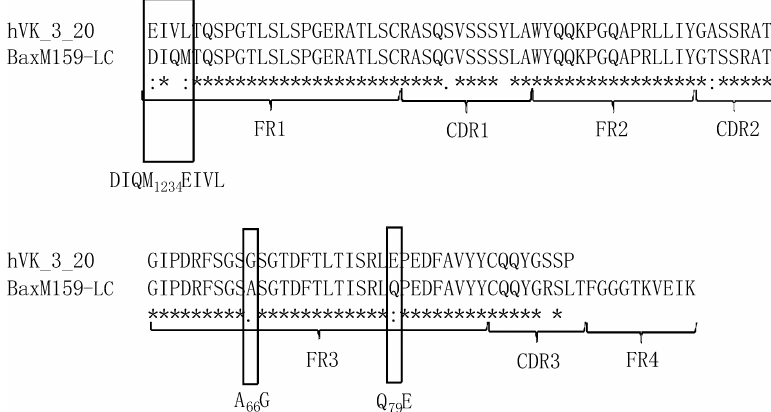
Figure 1. Comparison of BaxM159 VL sequence with germline VL subclass 3-20. Software clustal O was used for sequence alignment. * indicates identity, indicates similarity. Frame works, complementarity-determining region (CDR) identification, and amino acid numbering is indicated according to kabat scheme.